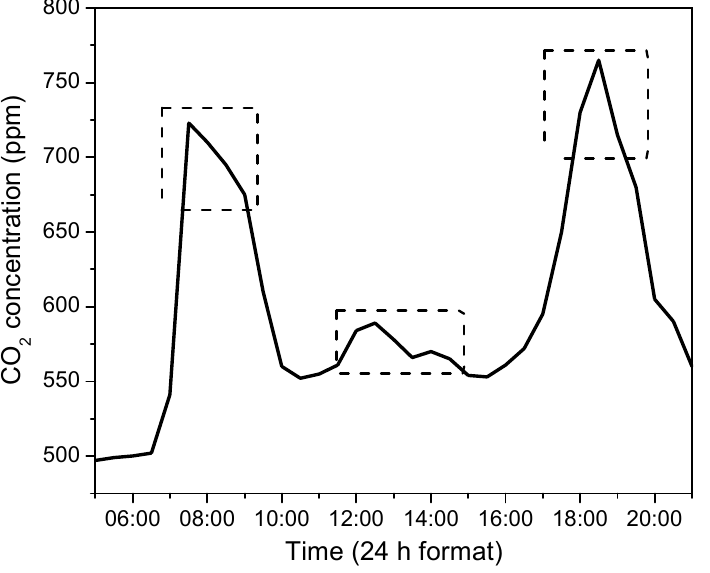
Figure 3. CO 2 average concentrations (from 5:00 to 21:00) considering records from all sensors over the 4 ‐ week period. Weekend data were not considered.